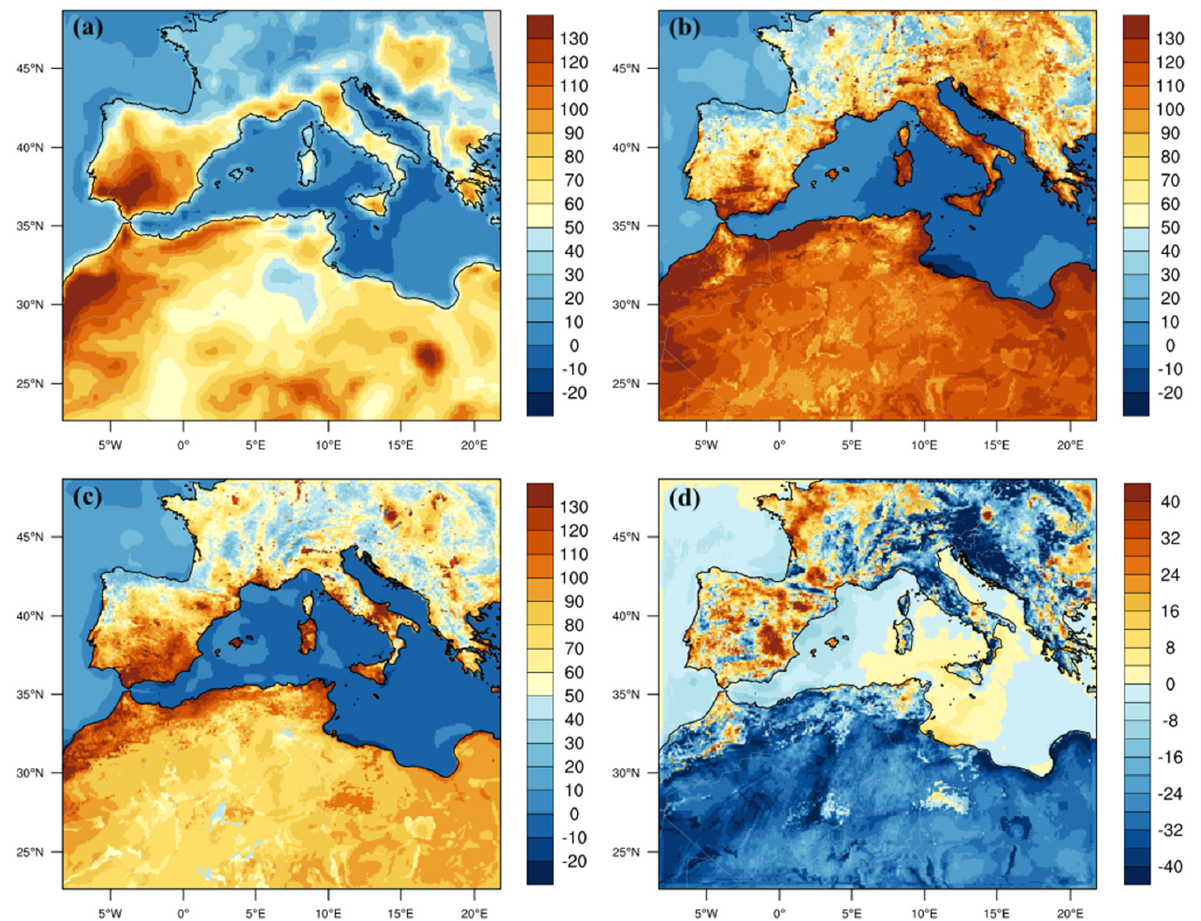
Figure 15. Simulated 8-day average sensible heat flux by ( a ) MERRA-2 model; ( b ) CTL, ( c ) FULL; ( d ) FULL − CTL. Units are W m − 2 .